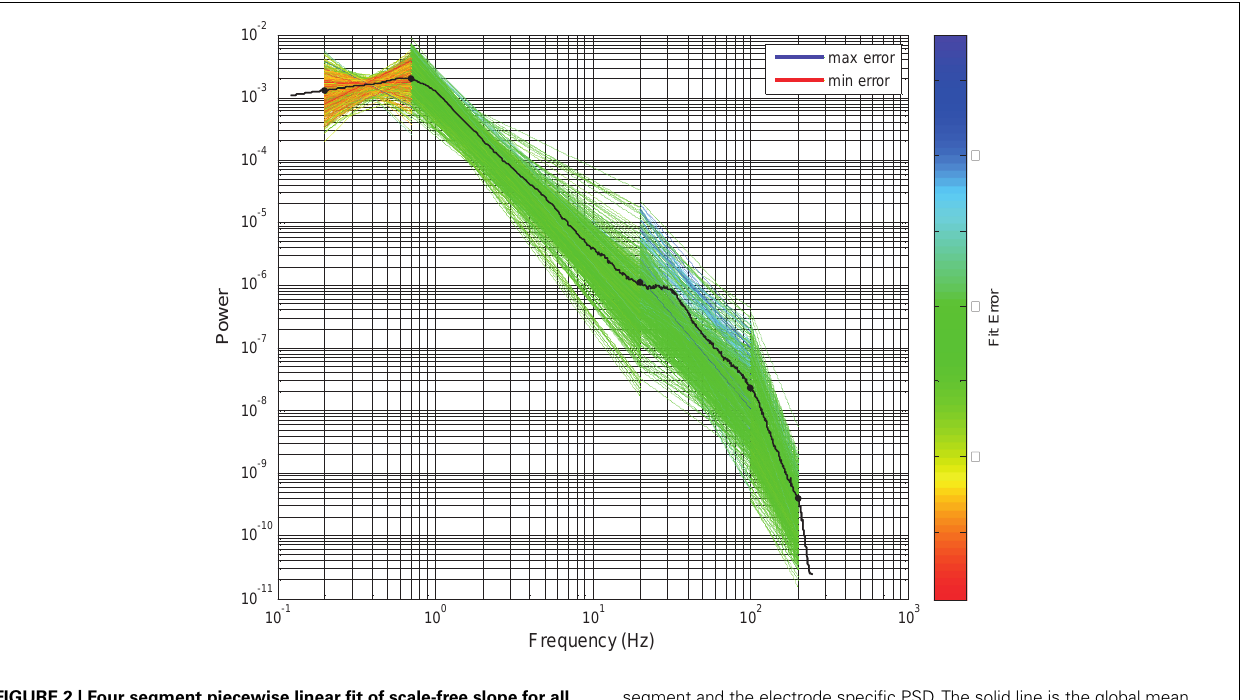
FIGURE 2 | Foursegment piecewise linear fit of scale-free slope for all electrodes in subject 1 in SWS. Each slope fit line is colored according to the line fit error, computed as the absolute difference between that line